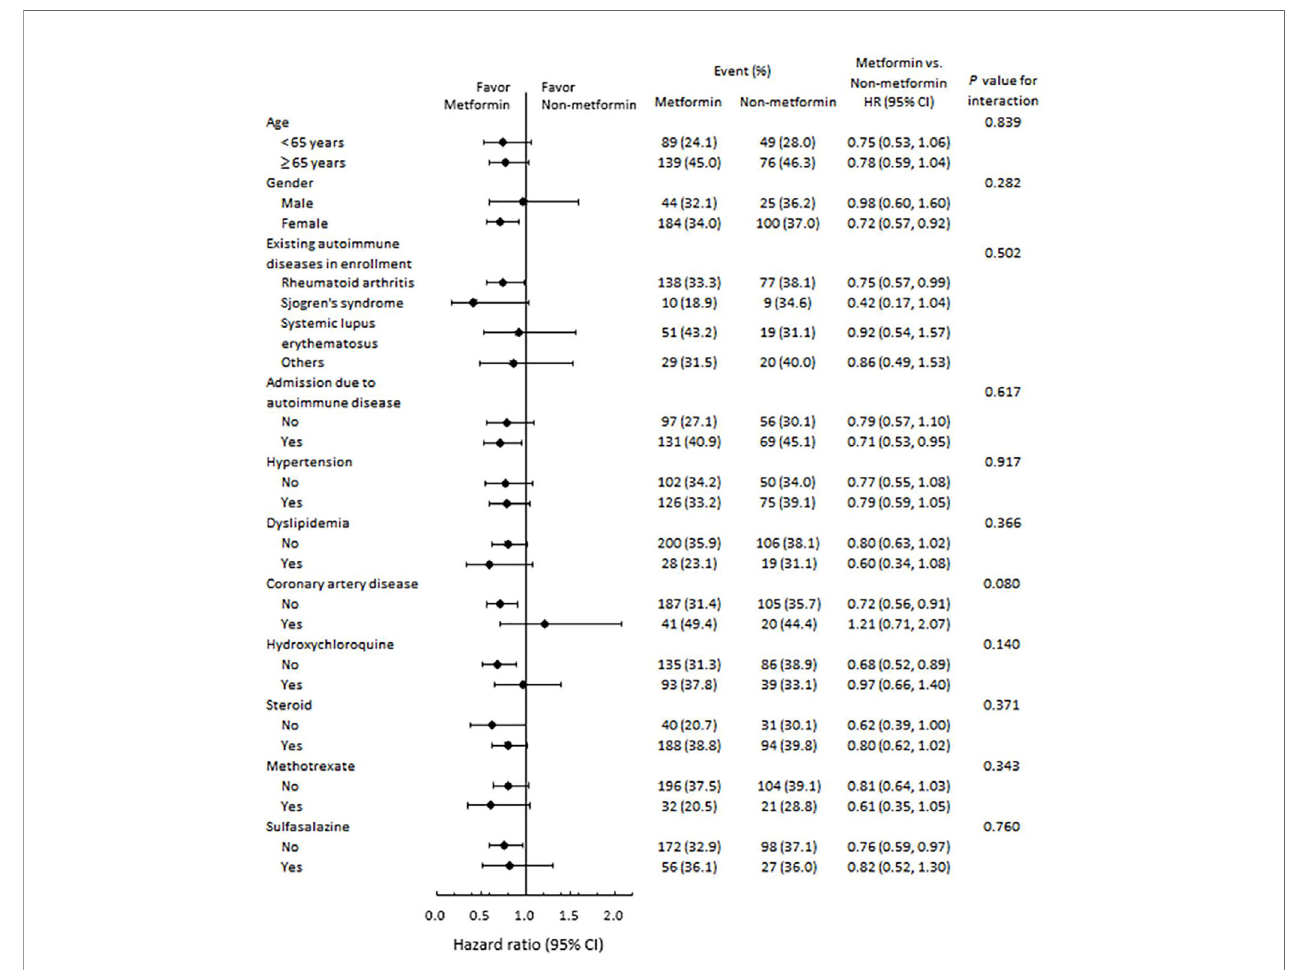
FIGURE 3 | Subgroup analysis of all-cause mortality. The bene fi cial effects of metformin on risk of mortality were similar across various strata.